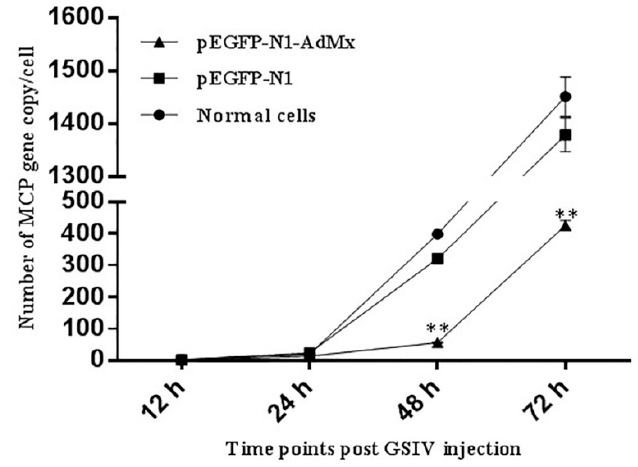
Figure 8. MCP gene copies at indicate times post GSIV infection. MCP gene copies in normal GSM cells, pEGFP-N1 transfected GSM cells and pEGFP-N1-AdMx transfected GSM cells at 12 h, 24 h, 48 h and 72 h post GSIV infection were determined by ddPCR. Error bars indicate the mean ± SD ( n = 3). The asterisks indicate significant difference (** p < 0.01) between treated and control groups.